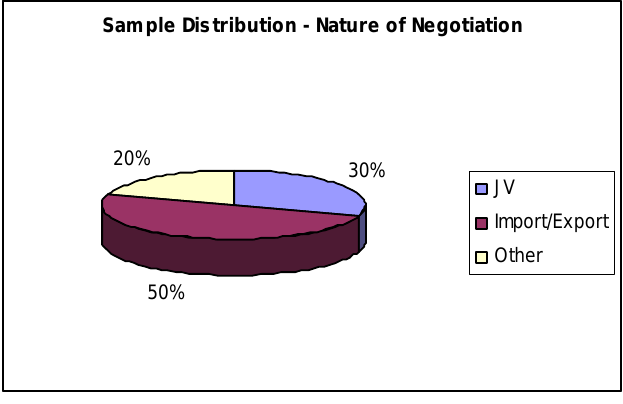
Figure 1: Sample distribution reflecting nature of negotiation